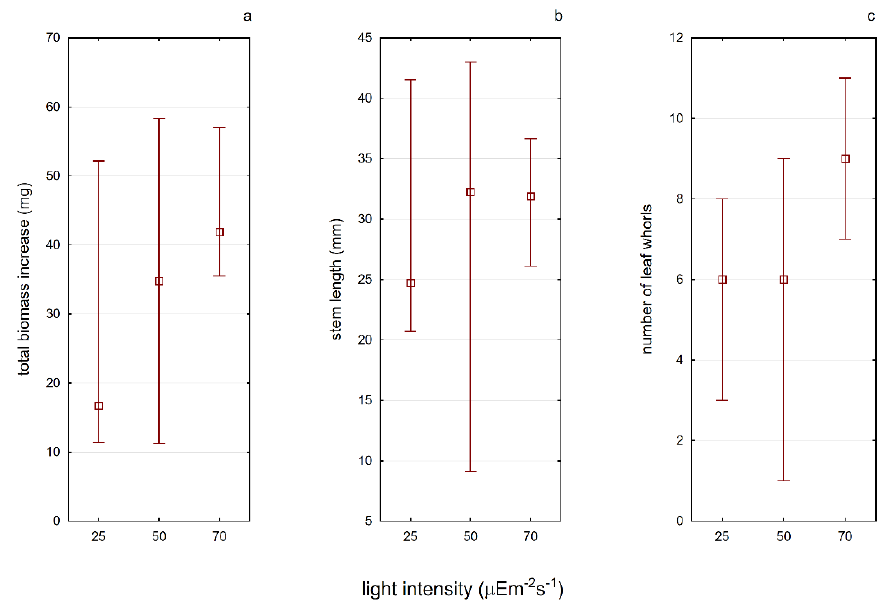
Figure 5. The influence of different light conditions on the tested plant characteristics (( a )—total biomass increase, ( b )—stem length, ( c )—number of leaf whorls) determining the efficiency of its growth in laboratory conditions. Whiskers indicate extreme values, and squares indicate the median. Content of photosynthetic pigments in Aldrovanda vesiculosa plant material in the chosen experiments (control—values at the beginning of the experiments; Chl a —chlorophyll a ; Chl b —chlorophyll b , Car—carotenoids, ∑ —sum of photosynthetic pigments; Chl a/b —ratio of chloro- phyll a to b